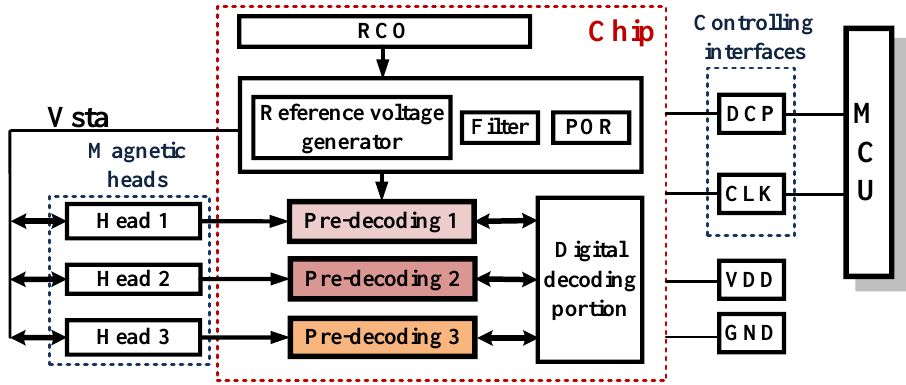
Figure 2. Diagram of the system architecture. The card swiping system is composed of read heads, a triple-track magnetic sensor chip and the controlling interfaces. The triple-track magnetic sensor chip contains RCO, RC filter, POR, the reference voltage generating circuit, pre-decoding circuits and digital decoding